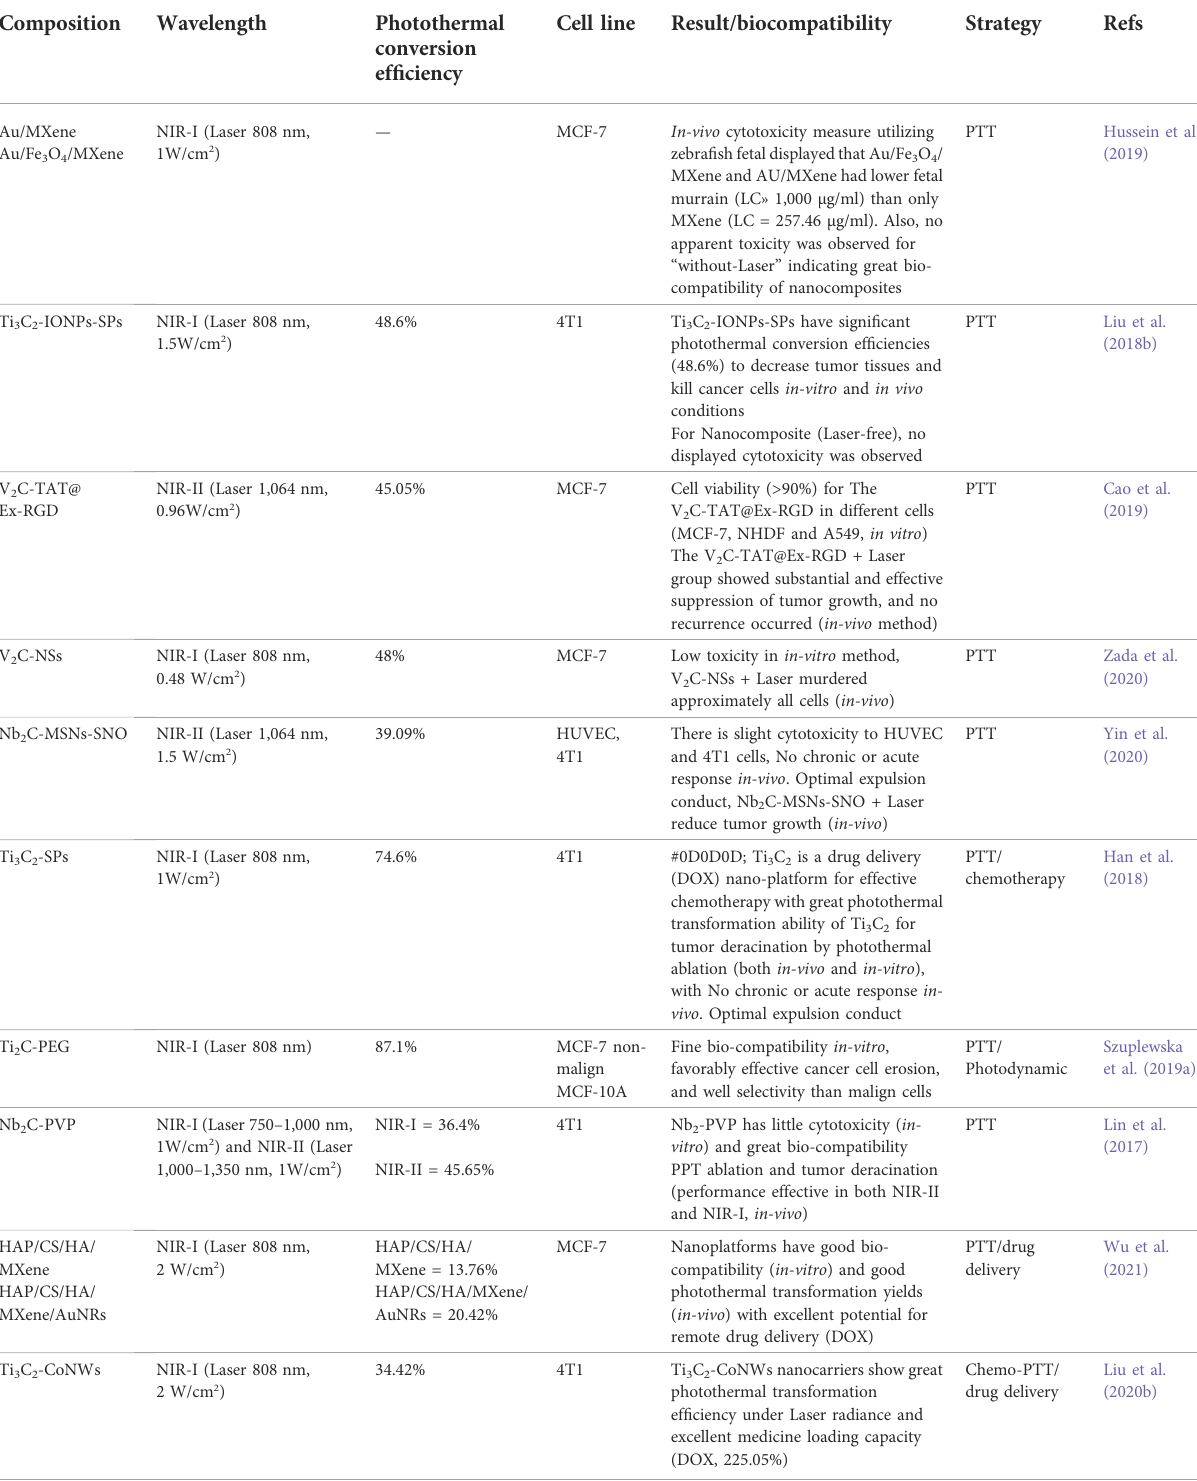
TABLE 3 Investigated biocompatibility, photothermal conversion ef fi ciency, and the effect of MXene nanoplate cell ablation on different types of breast cancer cells.